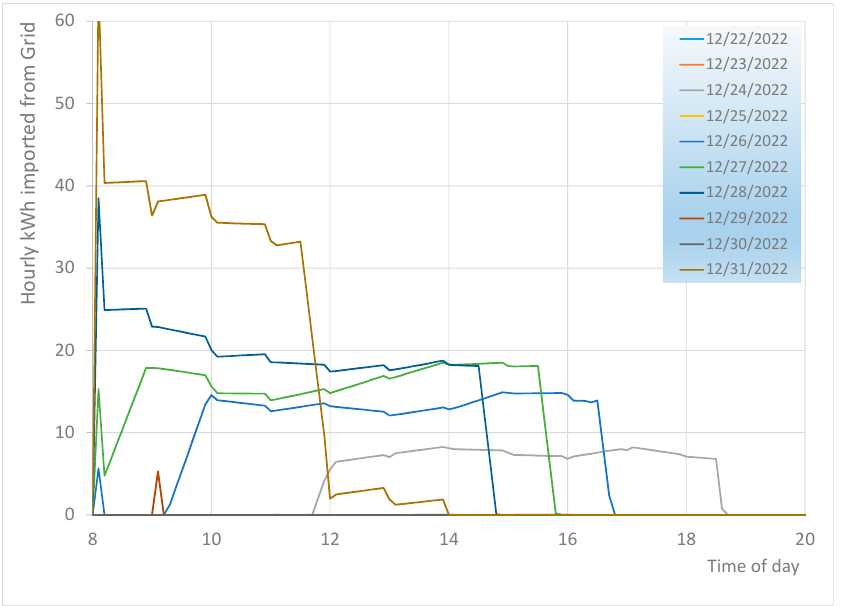
Figure 18. Hourly distribution of electricity imported from the grid for the last 10 days of December.